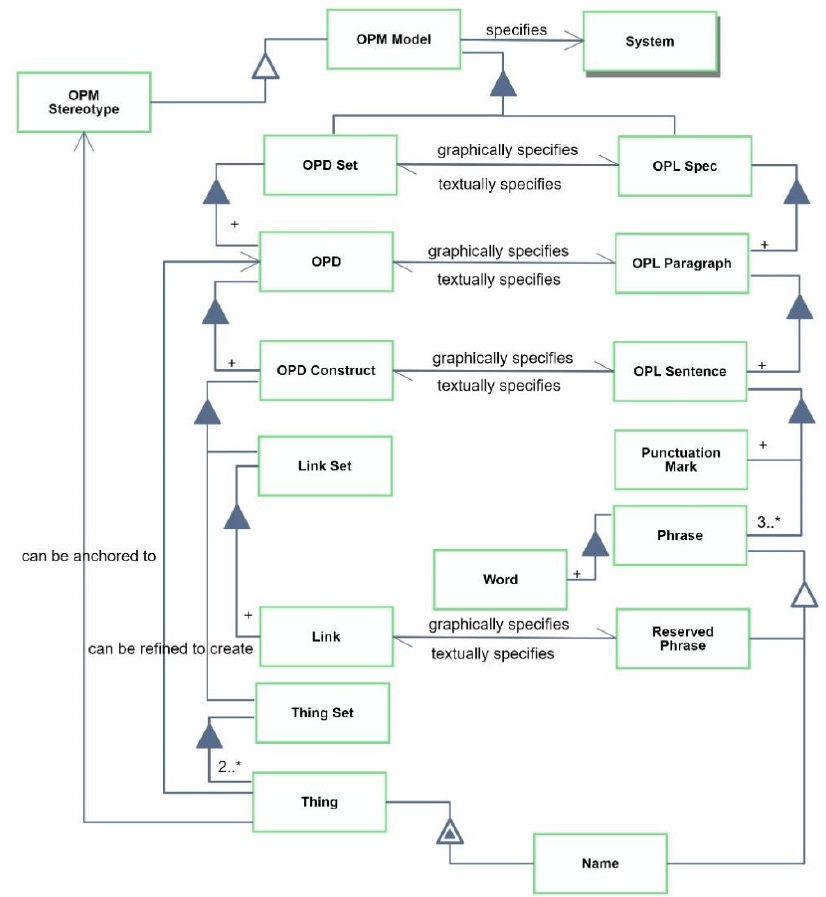
Figure 2. ISO 19450 OPM structure metamodel (ISO 19450:2015 Annex C) updated with OPM Stereotype